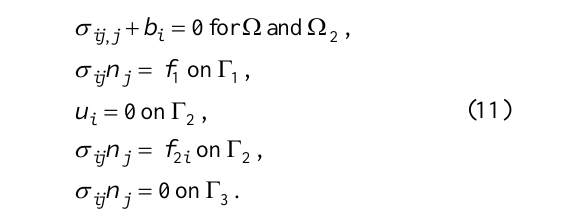
Fig. 6. Schematic ntinuum structure